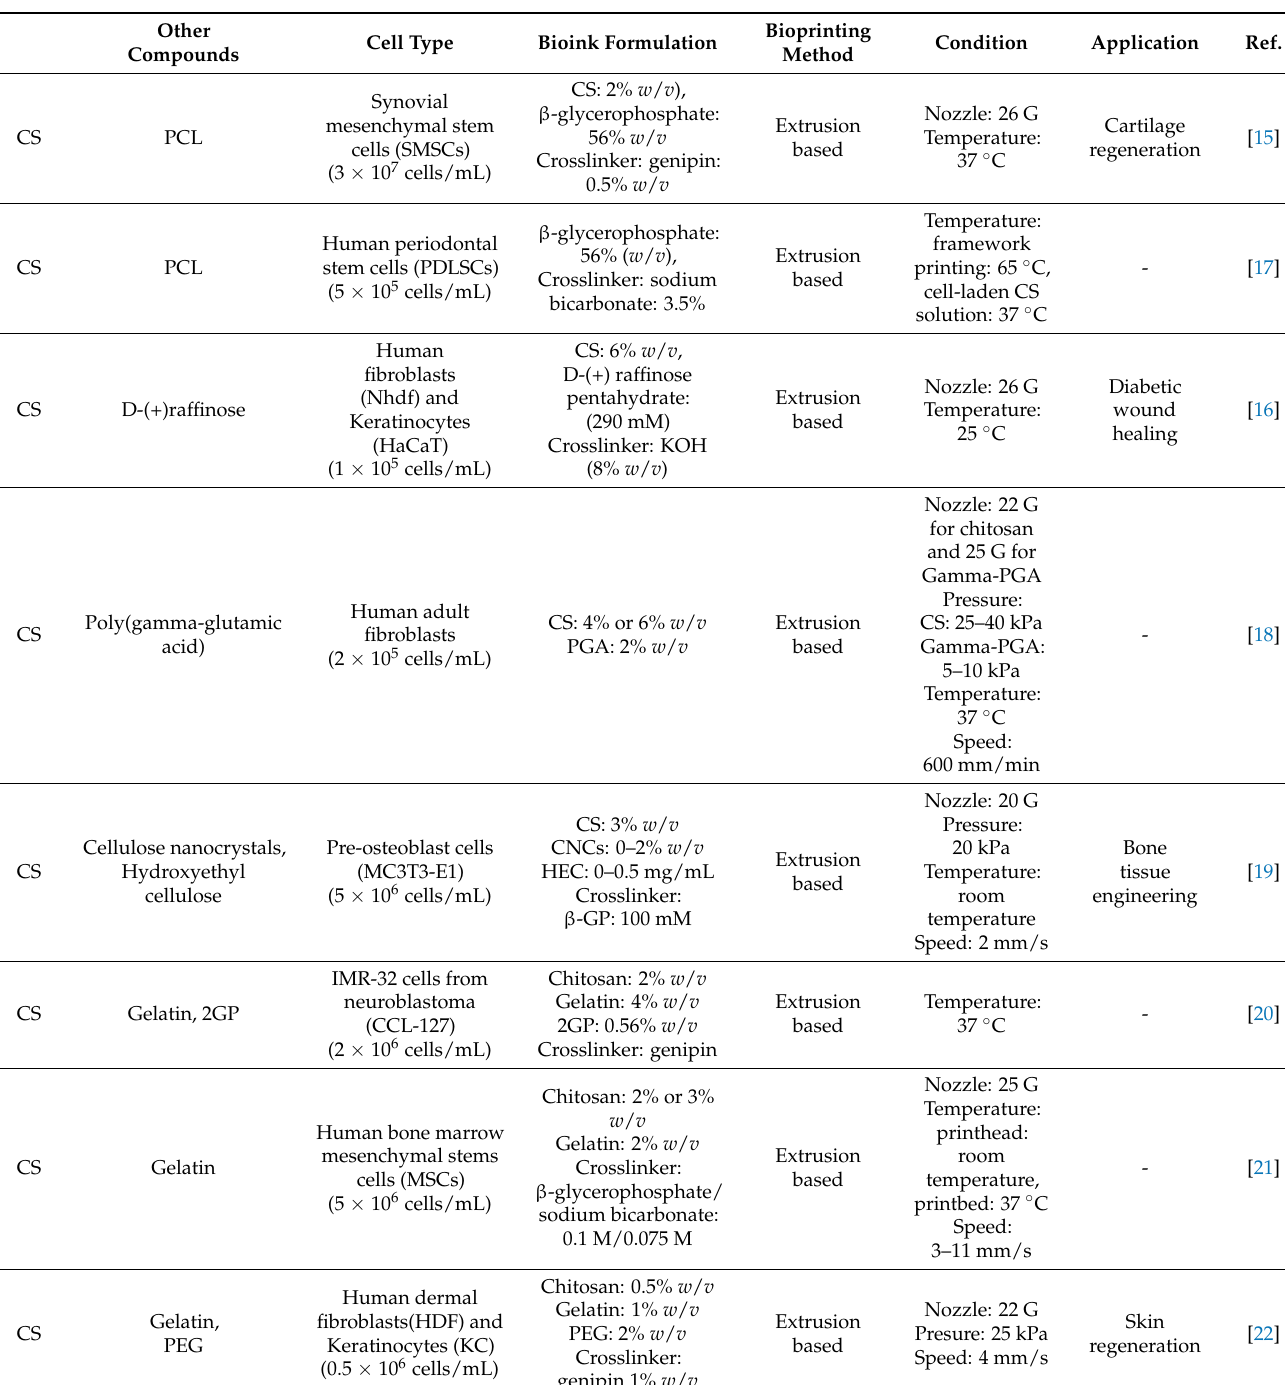
Table 2. Summary of the recent studies on chitosan-based